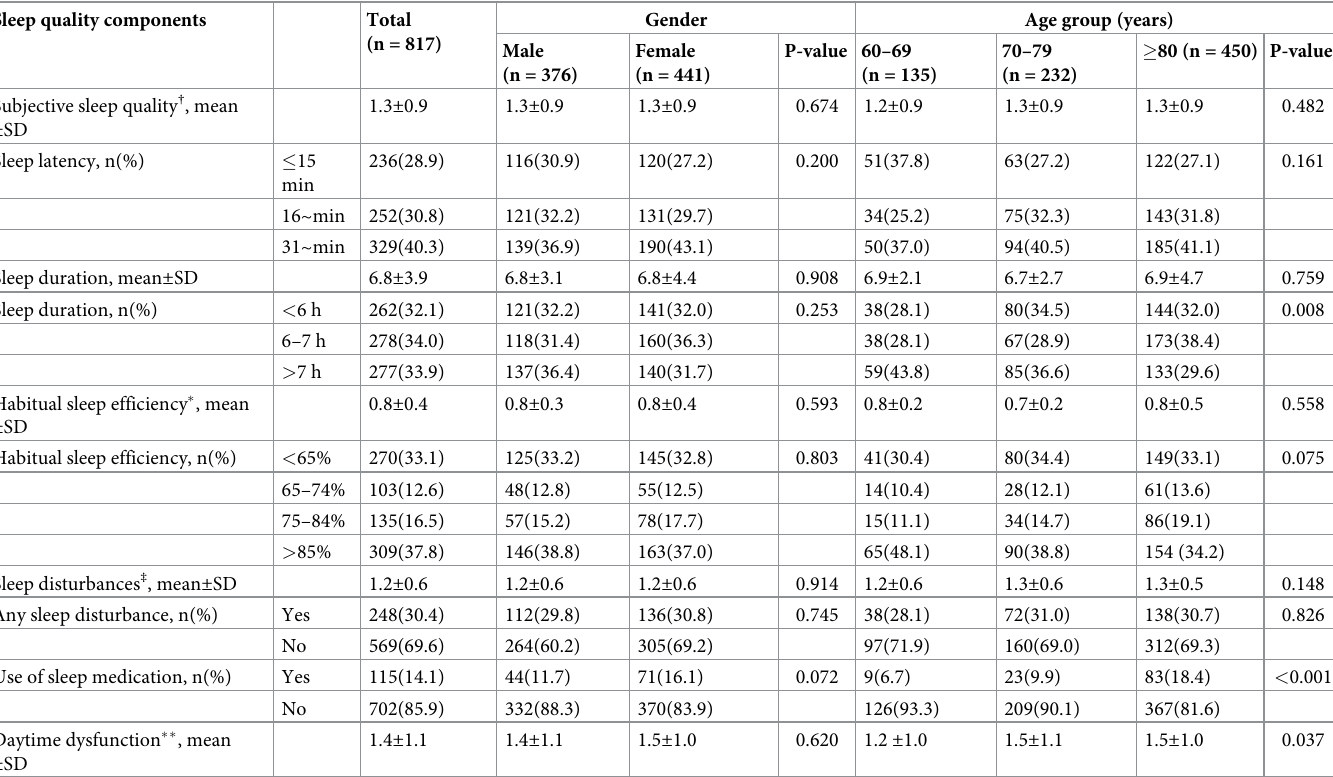
Table 3. Gender- and age-specific scores of sleep quality components measured by the Chinese version of the Pittsburgh Sleep Quality Index. Sleep quality